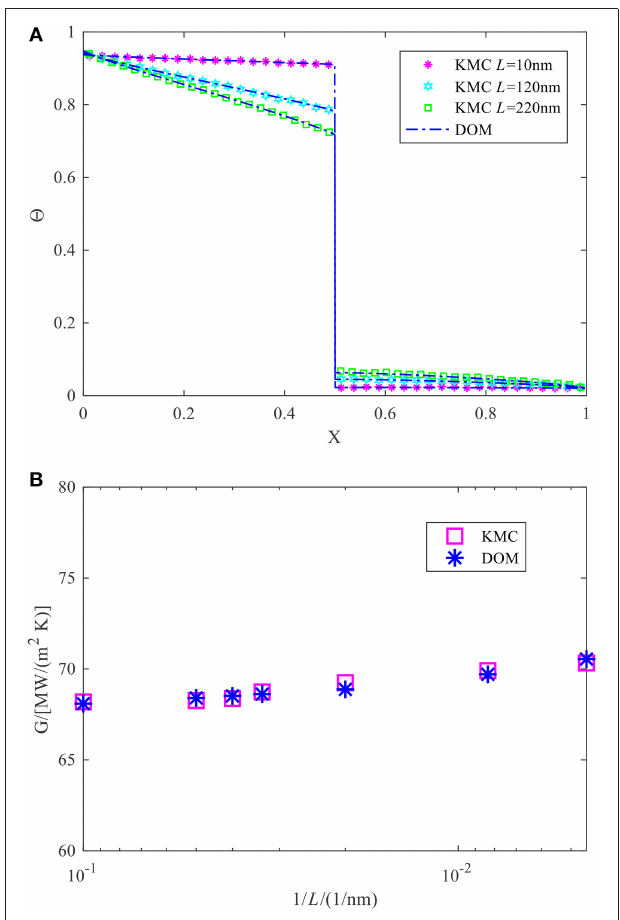
FIGURE 4 | The non-dimensional temperature distributions and thermal boundary conductances in cross-plane interfacial phonon transport across Ge/Si bi-layer thin film: (A) the non-dimensional temperature distributions for three cases with a total thickness 10, 120, and 220nm, respectively. Symbols are the results from the present Monte Carlo simulation whereas chain lines are that from the DOM scheme; (B) thermal boundary conductances vs. the inverse of total thicknesses.